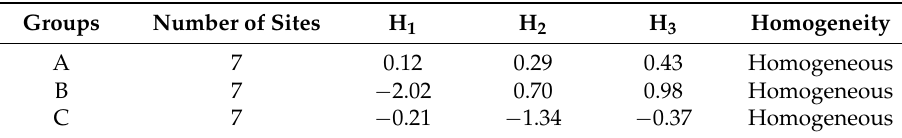
Table 5. Homogeneity measure of the final